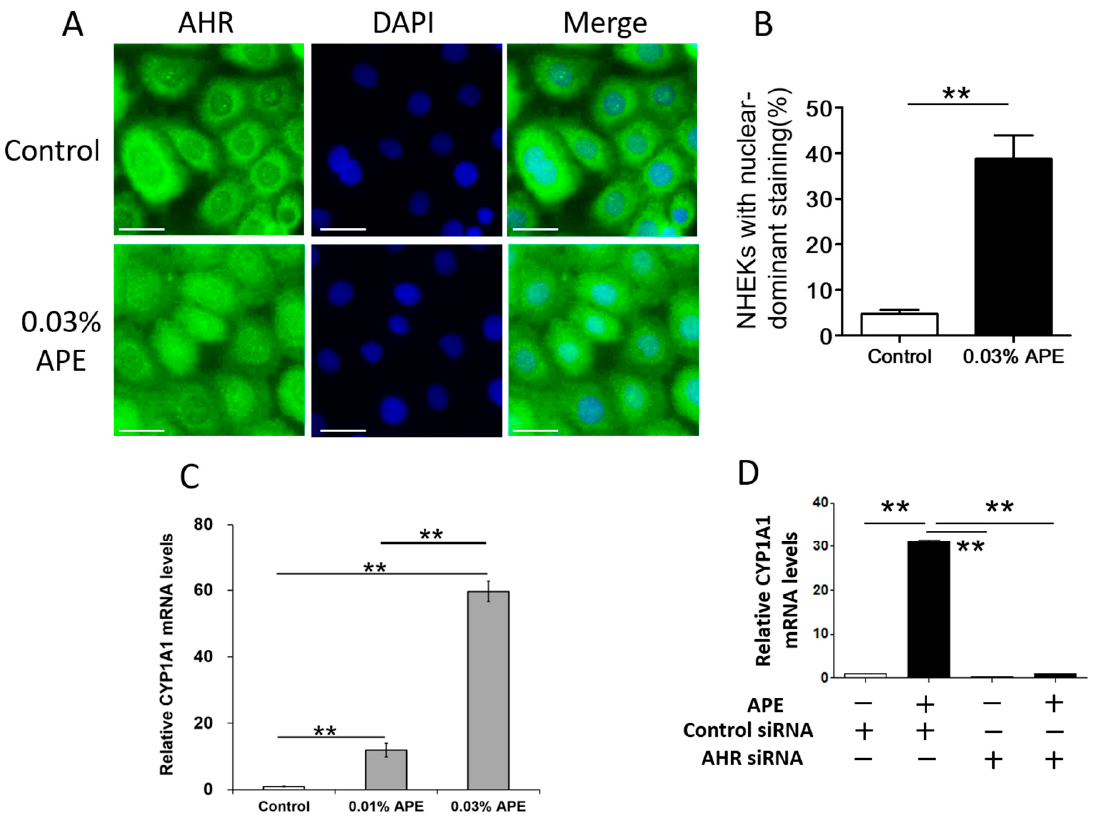
Figure 2. ( A ) Localization of AHR is visualized by an immunofluorescence technique. AHR is mainly located in the cytoplasm of control keratinocytes. Nuclear staining of AHR is enhanced in the keratinocytes treated with APE for 6 h. Nuclei are stained with 4 ′ ,6-diamidino-2-phenylindole (DAPI). Scale bar, 20 μ m; ( B ) the number of NHEKs with nuclear-predominant staining of AHR is significantly increased by APE treatment than that of control; ( C ) APE dose-dependently upregulates the gene expression of CYP1A1 , a specific AHR-responsive metabolizing enzyme. ** p < 0.01; and ( D ) APE-induced CYP1A1 upregulation is canceled in keratinocytes transfected with AHR siRNA. ** p < 0.01.